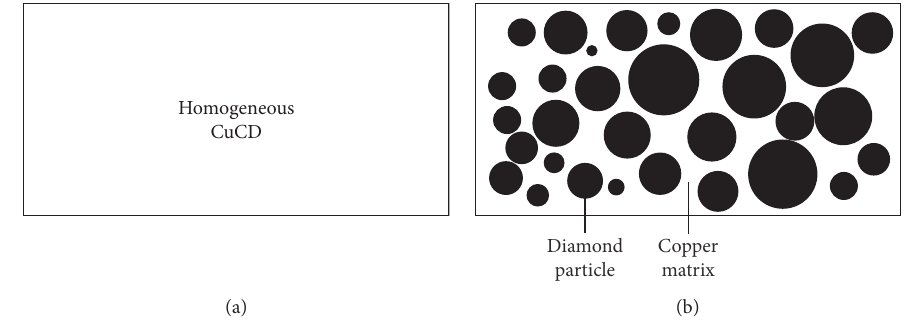
Figure 24: (a) Homogeneous and (b) mesoscale